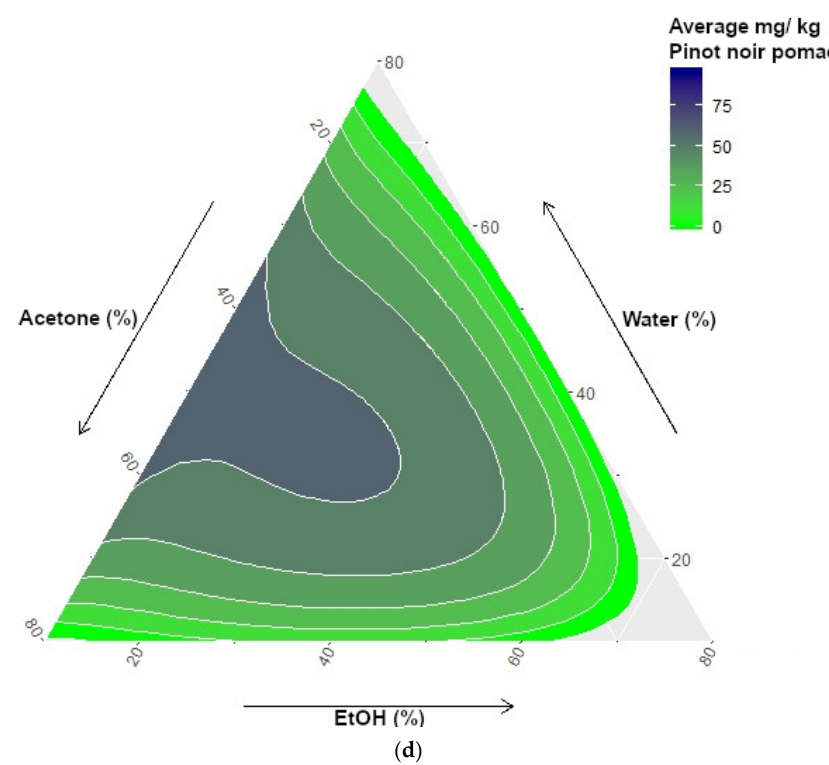
Figure 4. Ternary diagrams of: ( a ) the range of solvent systems trialed in this study (outlined in red), the optimal solvents for individual flavonoids (labelled 1, 2 and 3 in blue), the solvent boundaries to generate model diagrams of each flavonoid (outlined in green) and the optimal range of solvent systems for simultaneous extraction of all three flavonoids (outlined in blue); ( b ) solvent system effectiveness for extraction of 1 ; ( c ) solvent system effectiveness for extraction of 2 ; and ( d ) solvent system effectiveness for extraction of 3 . Table 4. The quantity of flavonoids extracted and their rank (out of 28) for each of the six solvent systems identified as optimal systems for the SLE for large-scale extraction.